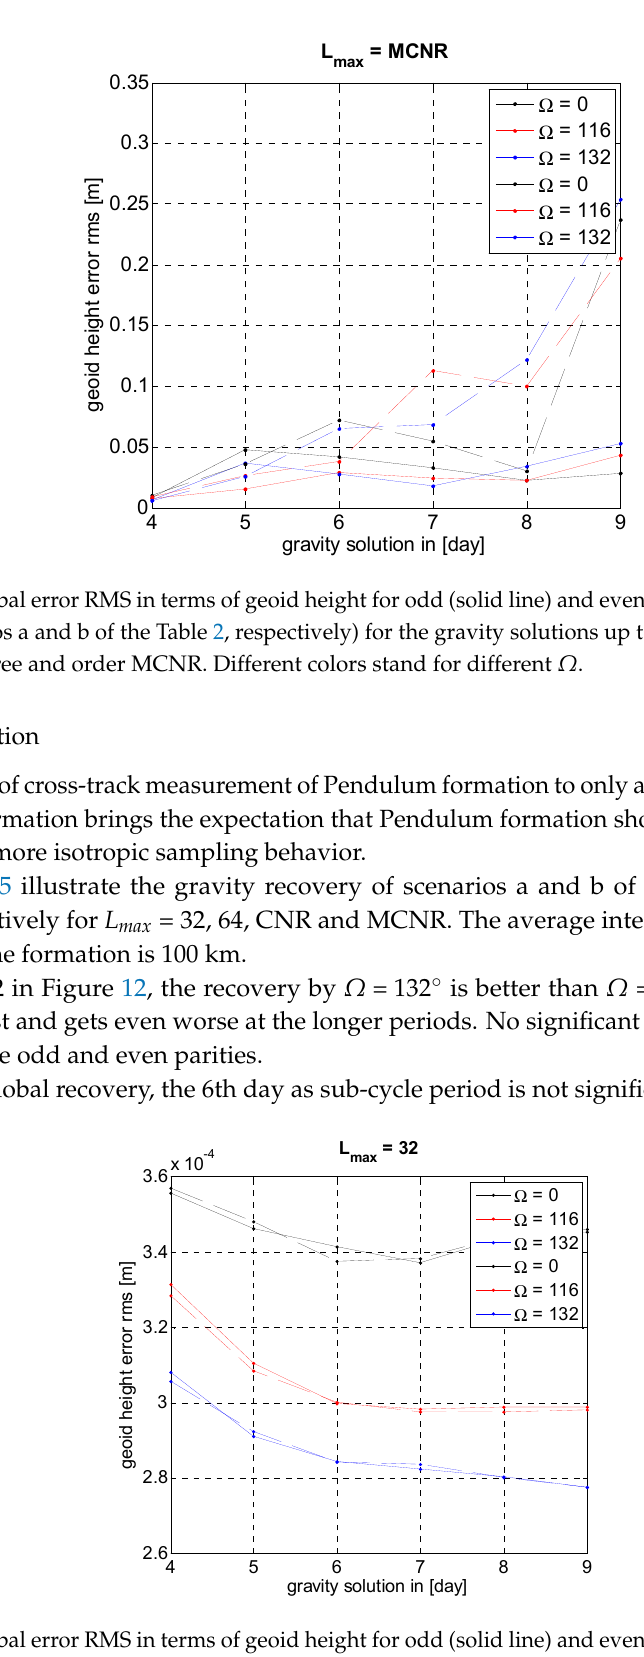
Figure 12. Global error RMS in terms of geoid height for odd (solid line) and even (dashed line) parities (Pendulum scenarios (a) and (b) of the Table 2, respectively) for the gravity solutions up to maximum spherical harmonic degree and order 32. Different colors stand for different Ω